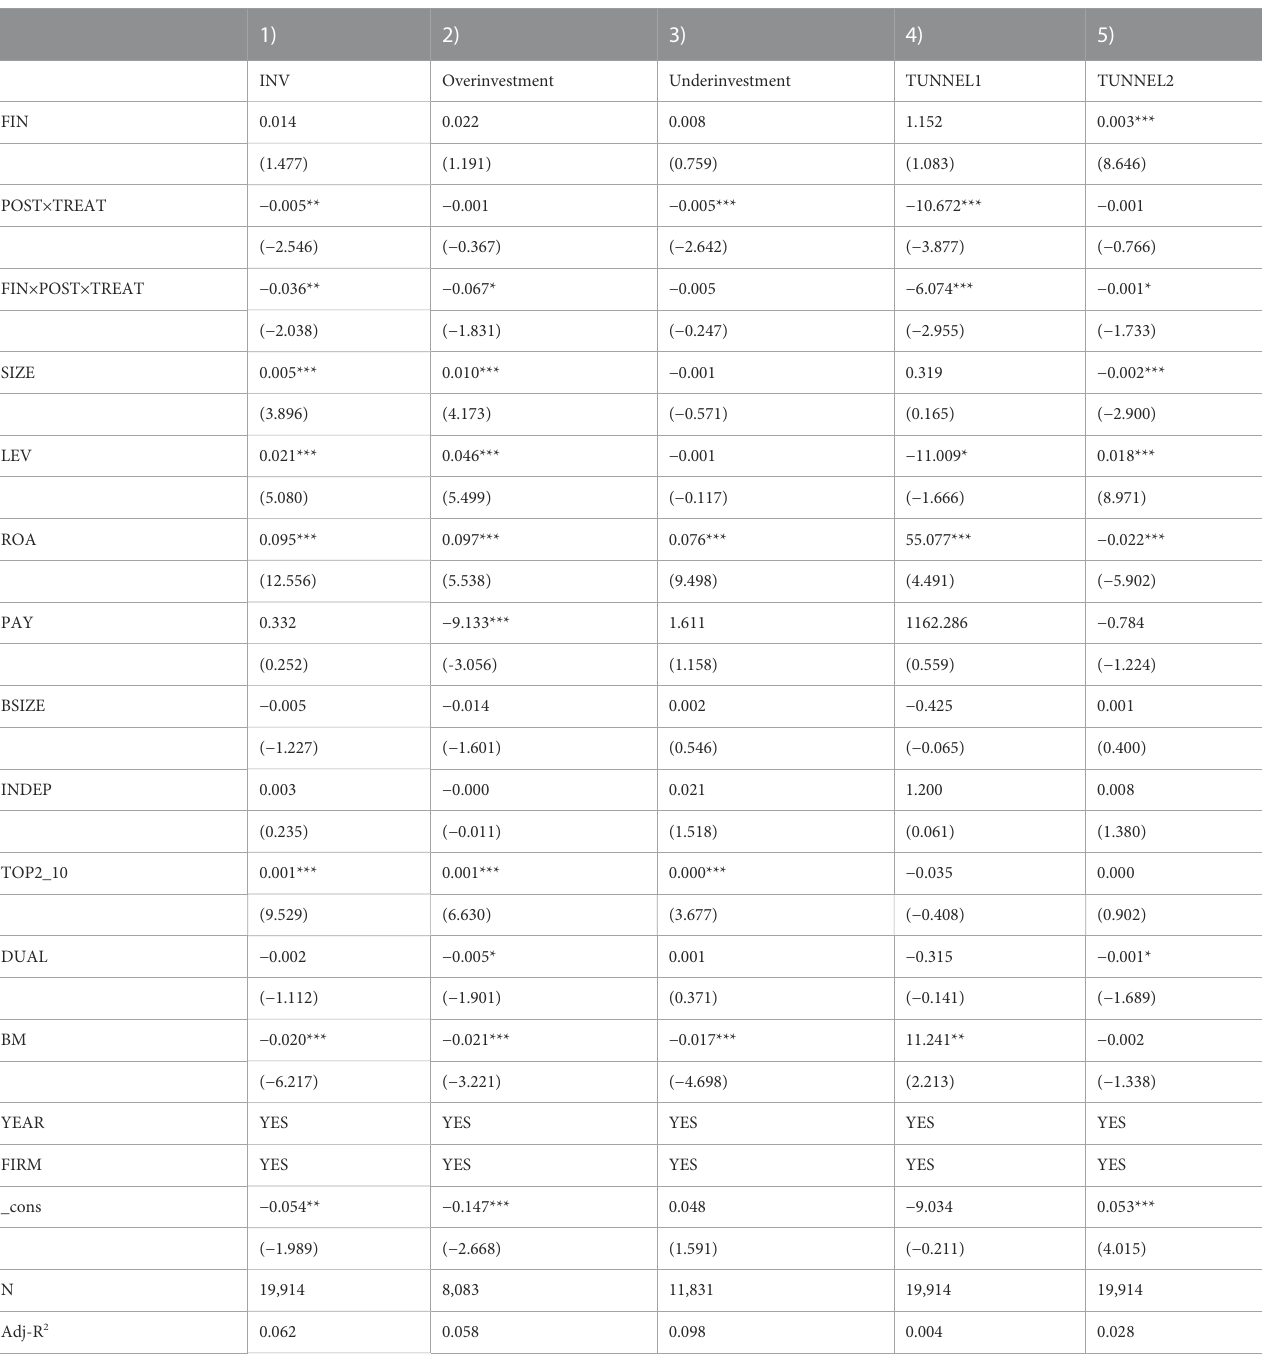
TABLE 12 Economic